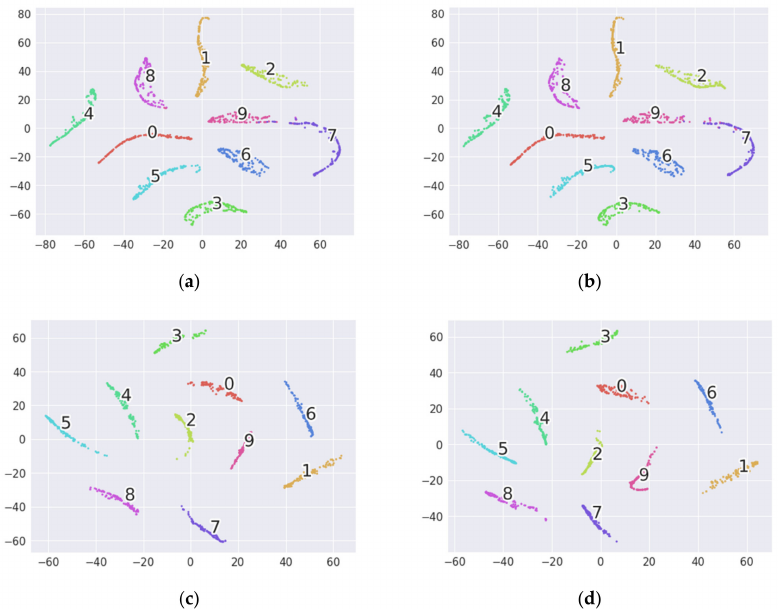
Figure 5. The two-dimensional visualization of the second full-connection layer of transfer task D → B. ( a ) WDMAN: source. ( b ) WDMAN: target. ( c ) 1D-MSDAN: source. ( d ) 1D-MSDAN: target. Category 0: No, Category 1: 0.007 / IF, Category 2: 0.014 / IF, Category 3: 0.021 / IF, Category 4: 0.007 / OF, Category 5: 0.014 / OF, Category 6: 0.021 / OF, Category 7: 0.007 / RF, Category 8: 0.014 / RF, Category 9: 0.021 / RF.